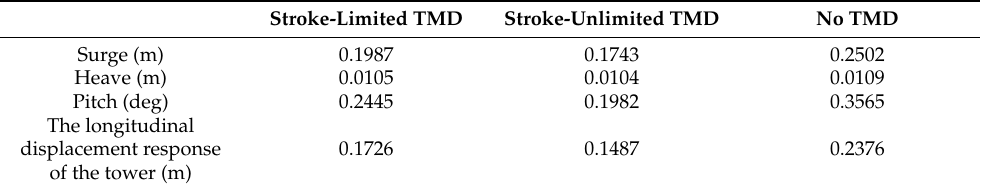
Table 17. Motion RMS with or without TMD stroke limitation under normal operating conditions.